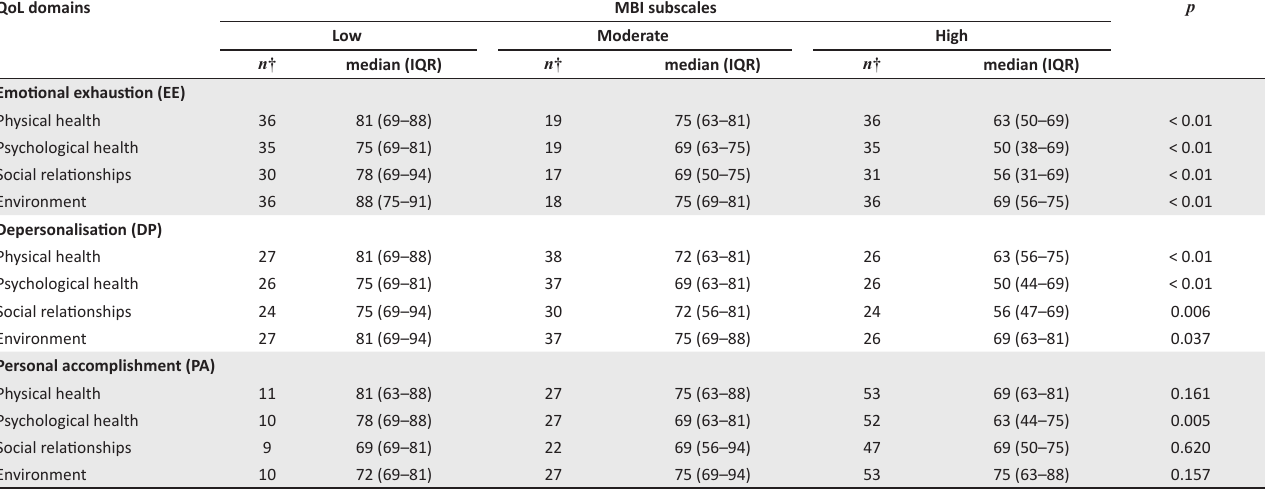
TABLE 2: Median scores of the quality of life domains in the Maslach Burnout Inventory subscale categories. QoL domains